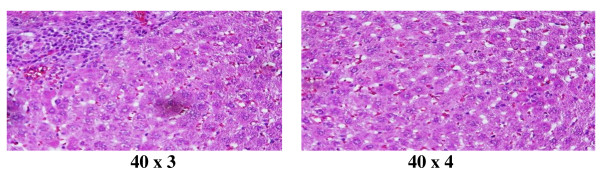
NPs-treated rat received 50 μl of 20 nm particles for 3 days